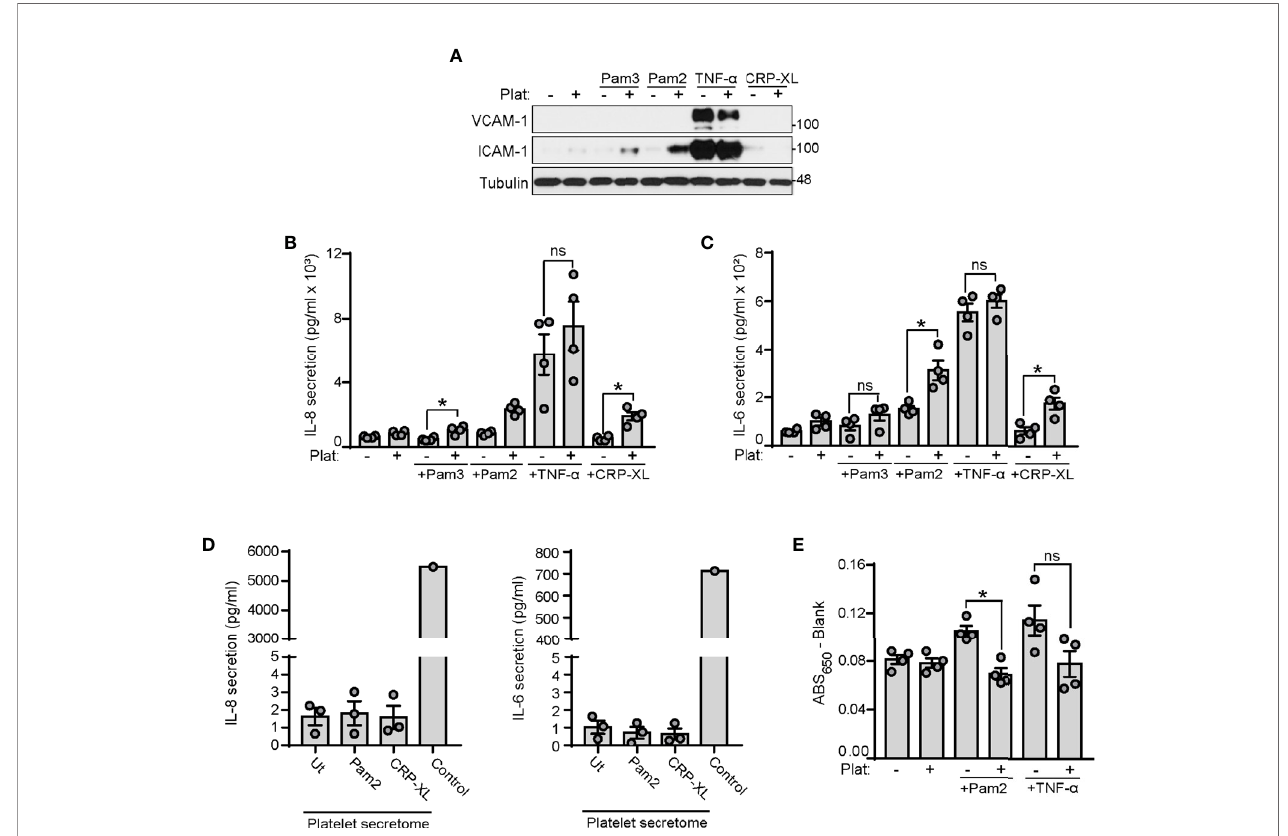
FIGURE 5 | Platelets enhance endothelial cell in fl ammation and reduce endothelial permeability to BSA in response to TLR2 agonists. (A – C) HUVECs were cultured onto 12-well plates until reaching con fl uence and stimulated with Pam2CSK4 (10 µg/ml), Pam3CSK4 (10 µg/ml) or TNF- a (1 ng/ml). 250 µl of platelets (2x10 8 /ml) were mixed with 250 µl of SFM and co-cultured with HUVECs for 4 hours. (A) Adhered platelets were thoroughly removed with SFM and HUVECs lysates analyzed for ICAM-1 and VCAM-1 expression by immunoblot; n=4 experiments. (B, C) Supernatants were collected and assayed by ELISA for IL-6 and IL-8 secretion; n=4 experiments. (D) Washed platelets (1x10 9 /ml) were stimulated with Pam2CSK4 or CRP-XL at 10 µg/ml for 45 min at 37°C. Platelets were then pelleted and supernatants assayed for IL-6 and IL-8 secretion. A positive control from TNF- a stimulated HUVECs was used (Control); n=3. (E) HUVECs were seeded to con fl uence in transwell devices and stimulated for 4 h at 37°C with Pam2CSK4 (10 µg/ml) or TNF- a (1 ng/ml) in the presence or absence of platelets (1x10 8 /ml). Cells were washed 3 times and incubated with media containing Evans Blue dye (0.67 mg/ml) and 4% BSA for 30 min at 37°C. Samples from the lower chamber were collected and absorbance at 650 nm measured; n=4. * indicates statistical signi fi cance (p<0.05). ns indicates not signi fi cant. Plat indicates platelets. Error bars indicate standard error of the mean